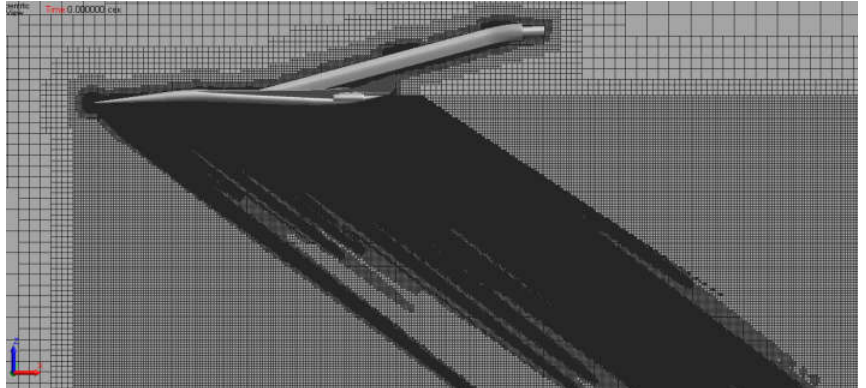
Figure 24. Computational grid, the second adaptation level (LM1021).